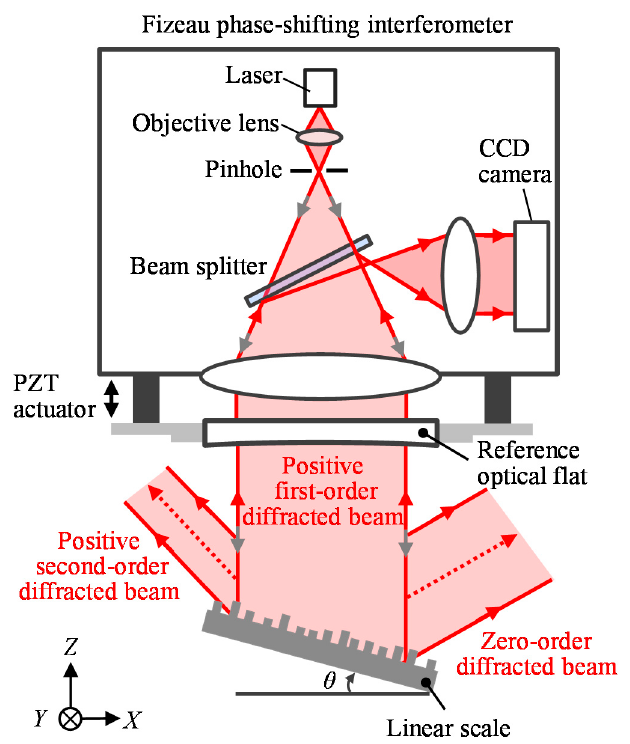
Figure 2. Measurement of the positive first-order diffracted beams from the grating by using the Littrow setup.